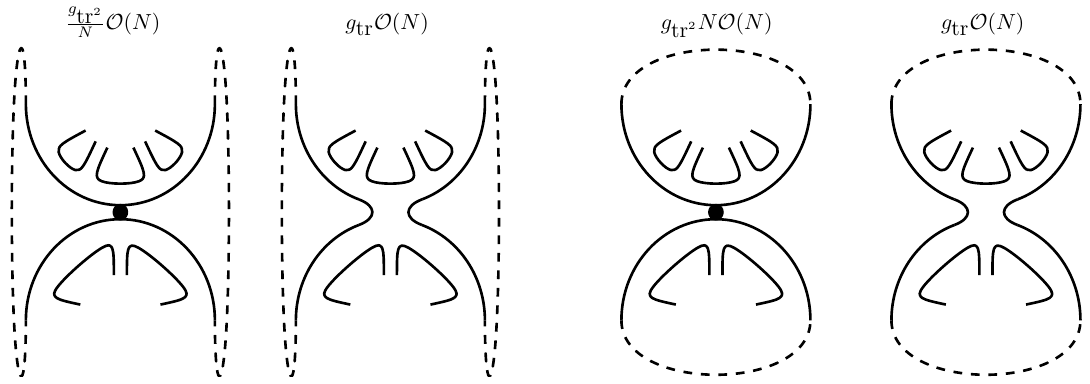
Figure 7 . We depict in the double line notation the e(cid:11)ect of replacing a generic double trace operator by a corresponding single trace construction, plausibly made out of several vertices. In the process the amount of loops either increases or decreases by a